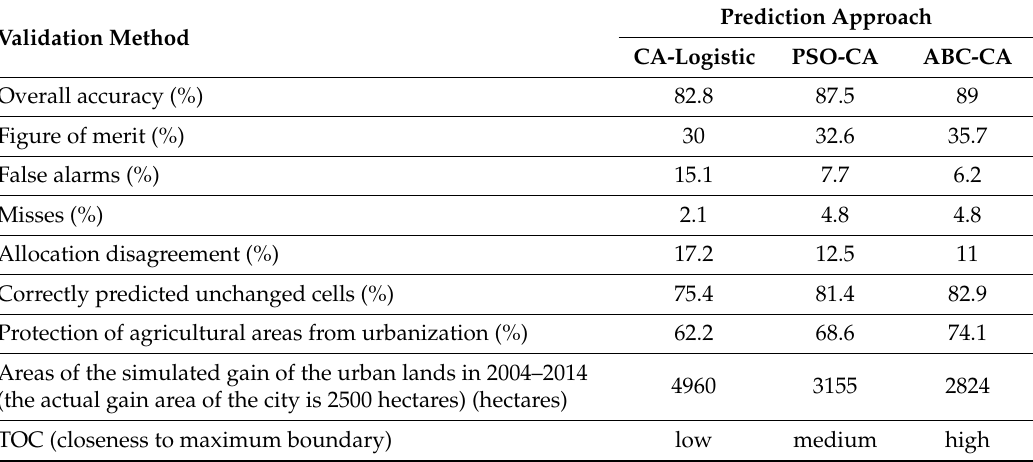
Table 4. Summery of the validation of the used models for urban growth